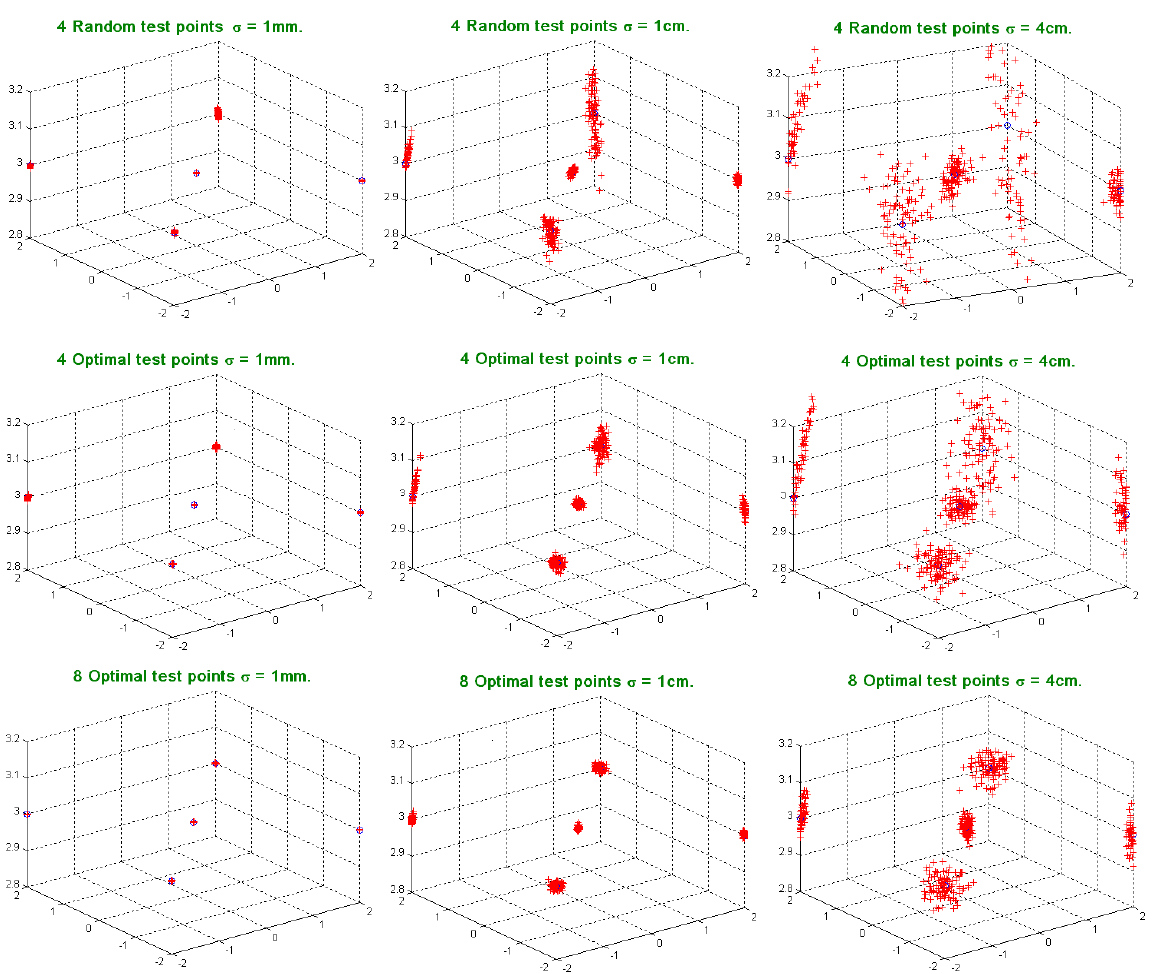
Figure 3. Representation of the 100 auto-calibrations for different noise levels in measurements (cid:2026) (cid:3404) (cid:4670)1 mm, 1 cm, 4 cm(cid:4671) , using four random unknown test points; four optimal unknown test points and eight optimal unknown test points (spherical case).